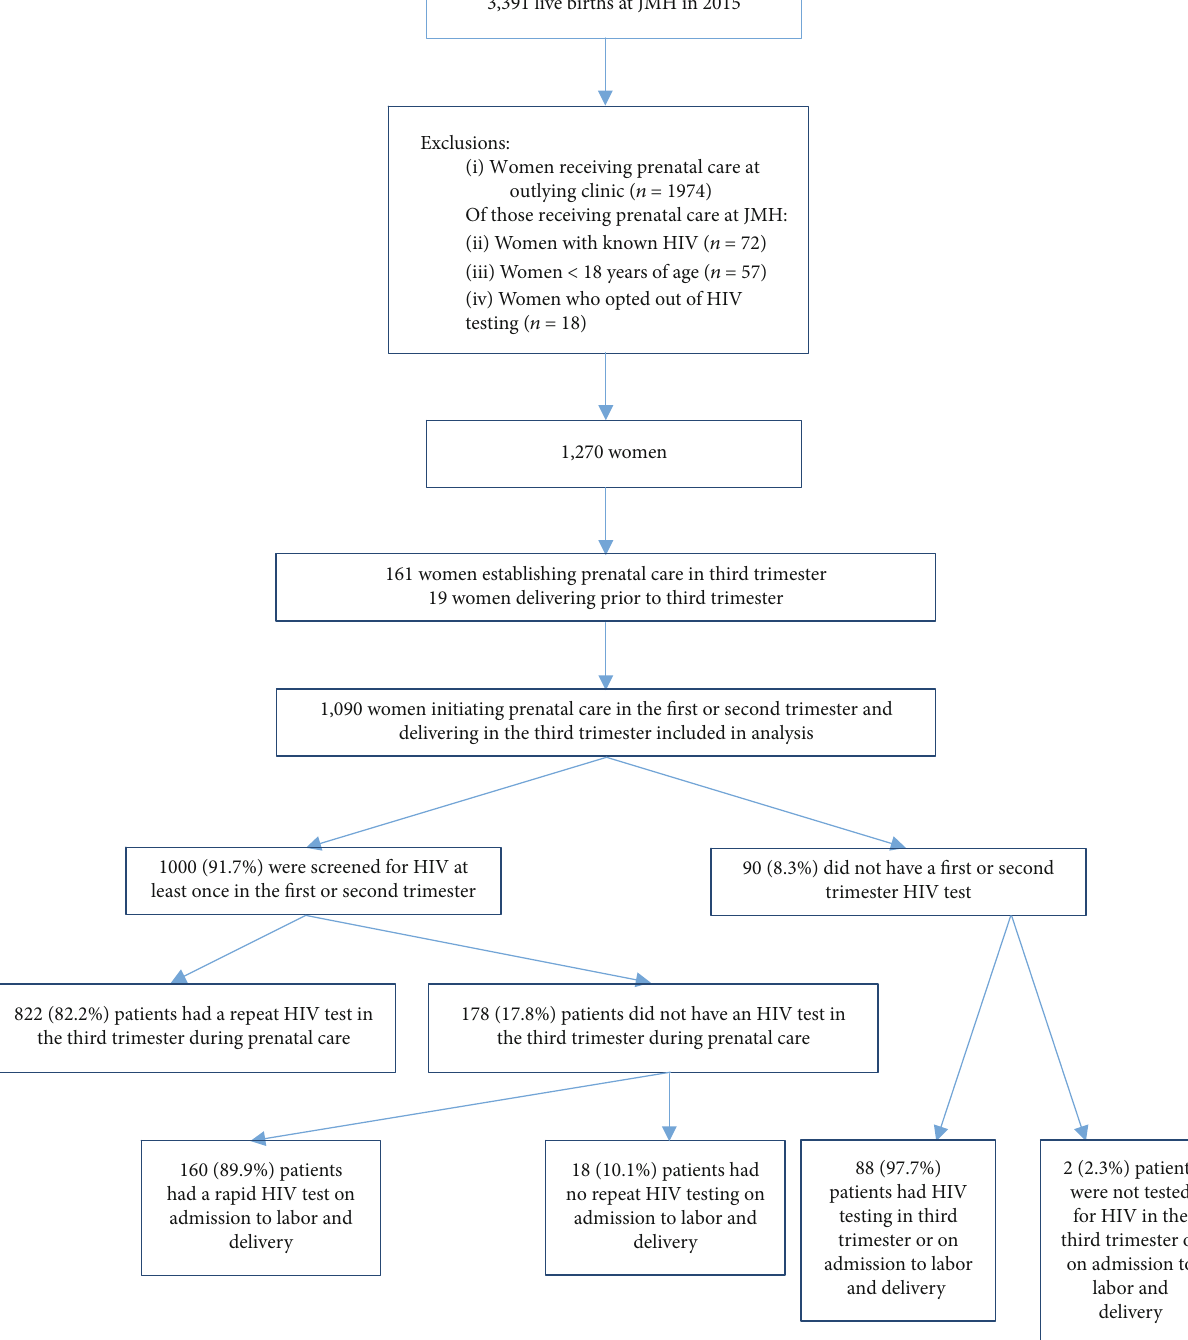
Figure 1: Flow diagram illustrating inclusion and exclusion criteria of patients in this study. Of those included in the fi nal analysis, prenatal HIV screening rates are shown according to CDC and ACOG